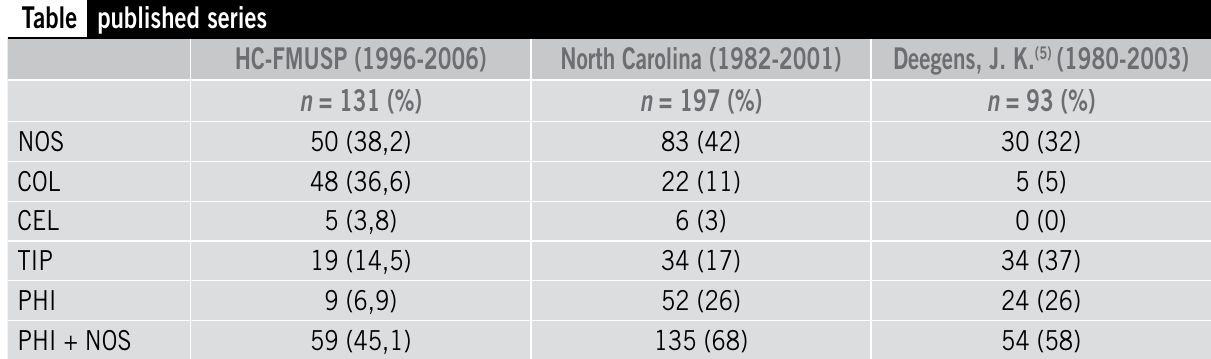
Classification of undiagnosed primary FSGS cases at the DAP-HC-FMUSP. Comparison with other published